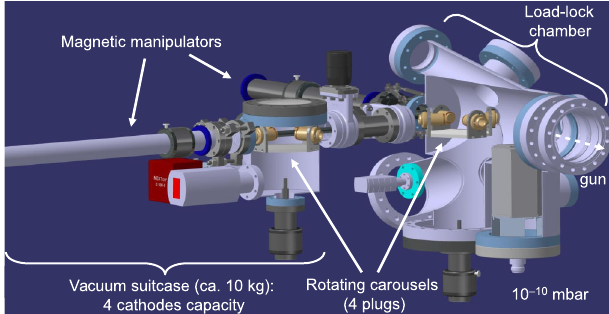
FIG. 7. 3D drawing of the vacuum suitcase connected to the load-lock chamber showing the cathode transfer principle and the two storage carousels.